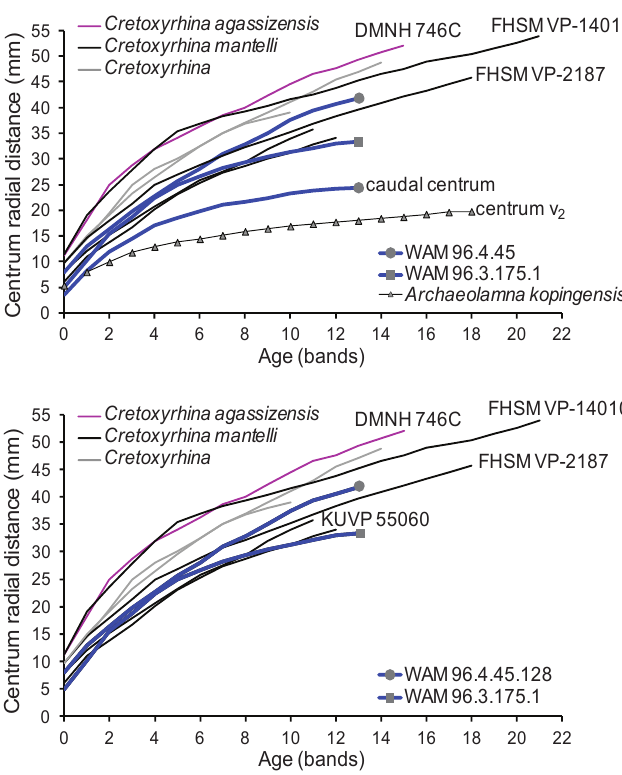
symbols).Fig. 10. Centrum growth profiles and size profiles of Cardabiodon